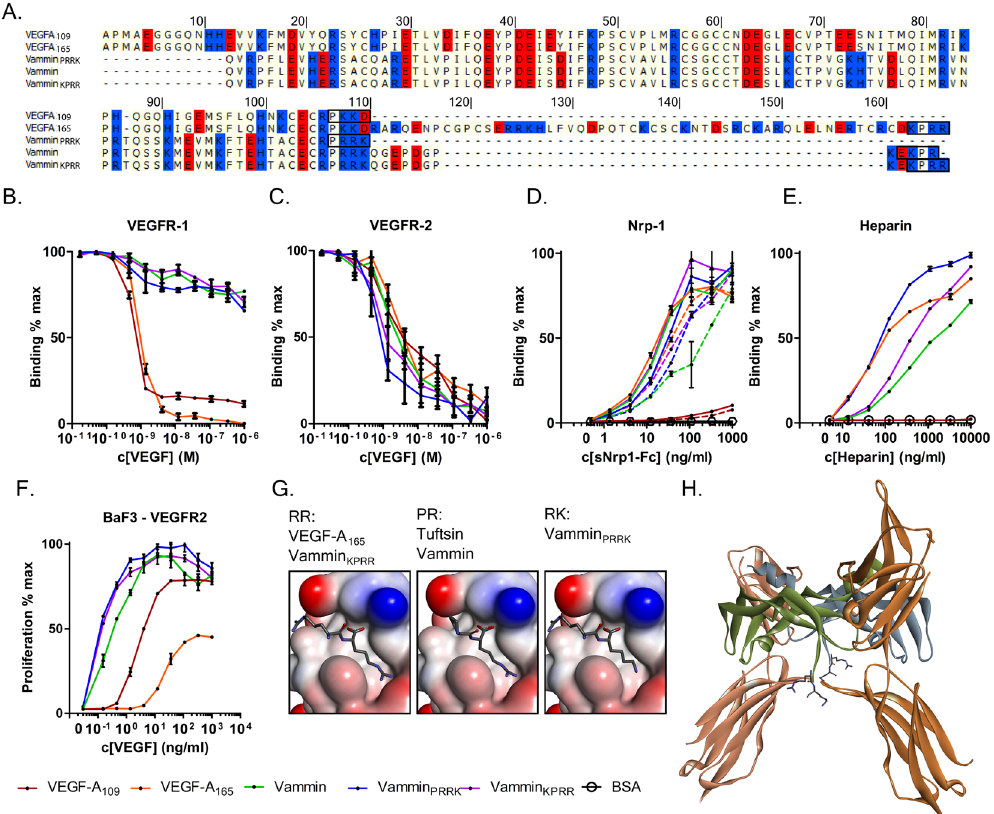
Figure 1. ( A ) Sequence alignment of recombinant VEGF-A and Vammin proteins. Basic amino acids are in blue and acidic in red background. The last four amino acids expected to be important for NRP-1 binding are in black boxes. ( B ) VEGFR-1 competition binding assay ( C ) VEGFR-2 competition binding assay ( D ) NRP-1 binding into VEGF coated plates the presence of heparin (solid lines) and without heparin (dotted lines) ( E ) Heparin binding in VEGF coated plates ( F ). BaF3-VEGFR-2 proliferation assay. In B to F the values are expressed as mean ± SD. ( G ) Binding of the two C-terminal amino acids into the NRP-1 binding pocket. RR and PR sequences are drawn based on VEGF-A 165 /NRP-1 and Tuftsin/NRP-1 complex structures. (PDB IDs 4DEQ and 2ORZ). RK sequence is modeled based on VEGF-A 165 /NRP-1 complex structure. Ligand amino acids are shown as sticks and NRP-1 as surface rendering colored by interpolated charge. ( H ) A model of location of the Vammin PRRK C-terminus. Vammin crystal structure (PDB ID 1 WQ8) was superimposed onto VEGF-C/ VEGFR-2 complex crystal structure (PDB ID 2X1W). The two VEGFR-2 monomers are seen with the brown colors and the two antiparallel dimer forming Vammin chains with green and blue. The C-terminal Arg97 and Lys98 of Vammin projecting outward from the complex are shown as